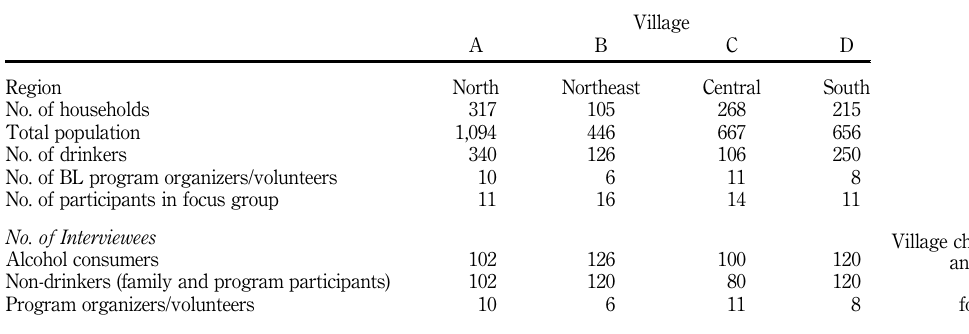
Table I. Village